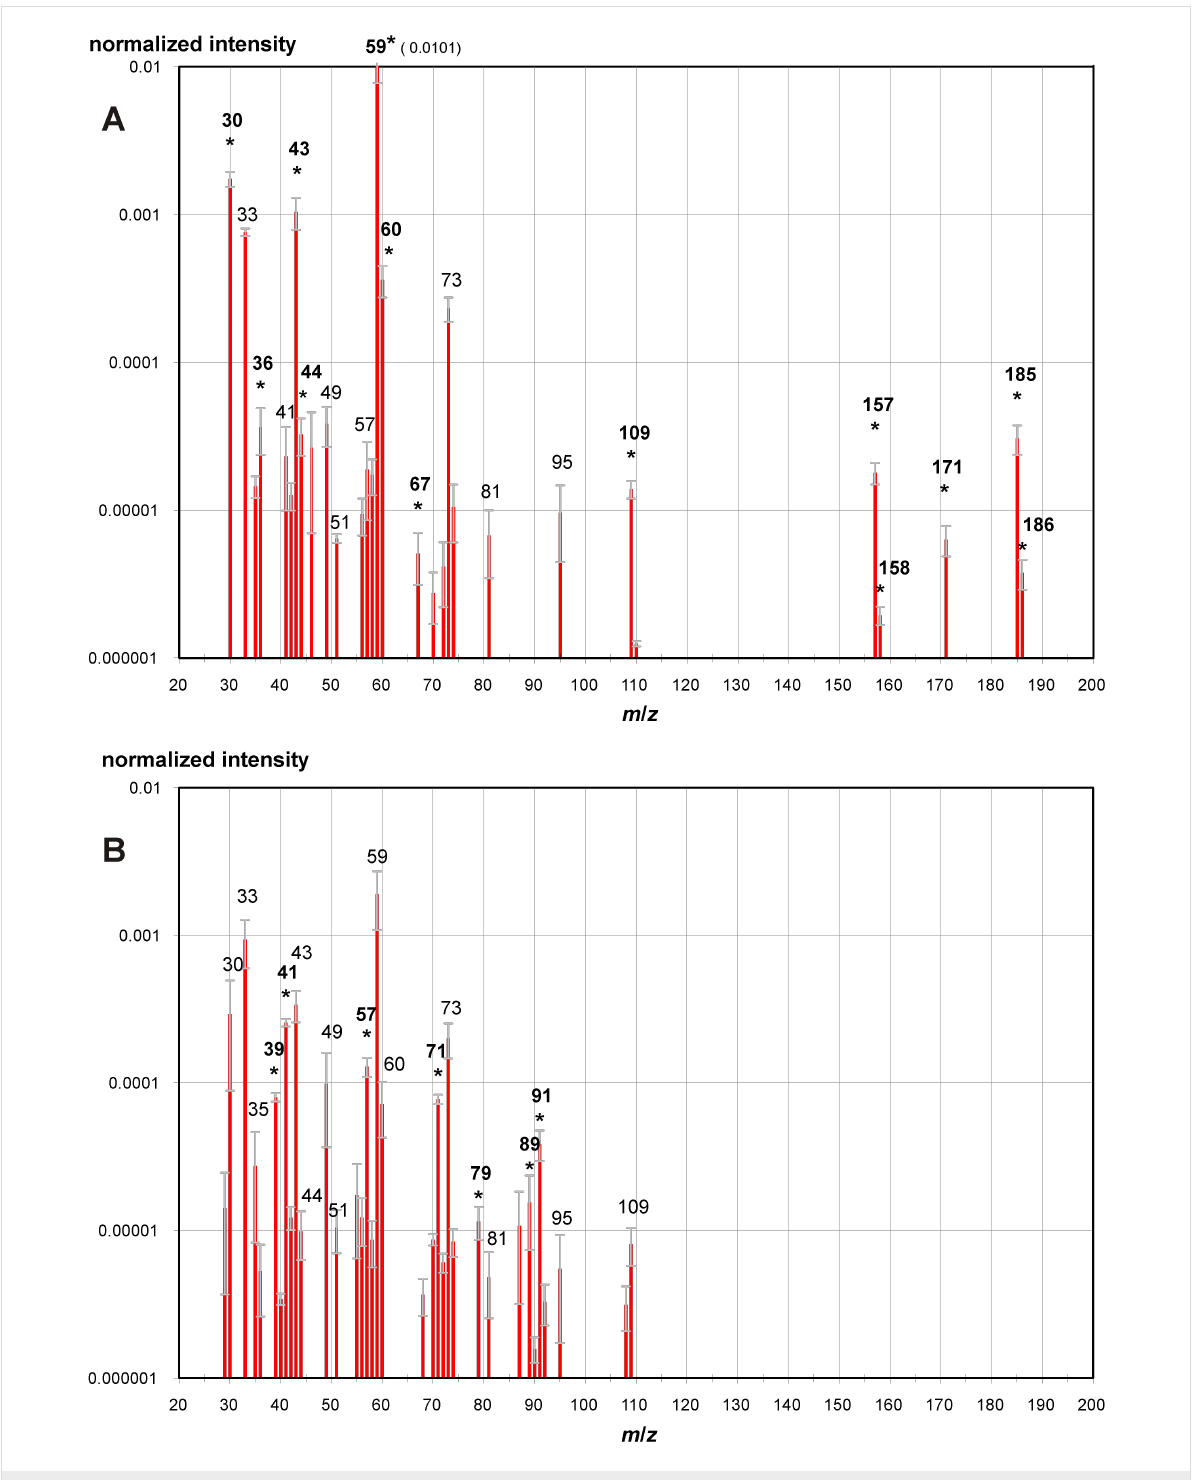
Figure 4: PTR–MS mass spectra of Xanthomonas campestris pv. vesicatoria 85-10 volatiles after three days of incubation. (A) PTR–MS profile scan of headspace volatiles of X. c. pv. vesicatoria 85-10 growing in a Petri dish with NB. (B) PTR–MS profile scan of headspace volatiles of X. c. pv. vesi- catoria 85-10 growing in a Petri dish with NBG. Spectra are normalized to the primary ion signal (H 3 O + ) and are blank corrected (i.e., spectra recorded from the respective media without bacteria are subtracted). Signals that are significantly influenced by the growth media (5% confidence level) are labeled by *. Only significant signals (mean subtracted by standard deviation) higher than 10 − 6 are shown and a log-scale on the ordinate axis is used. Note that missing signals therefore do not necessarily indicate zero concentration but may also be due to the variance of the sample or a blank signal higher than the mean